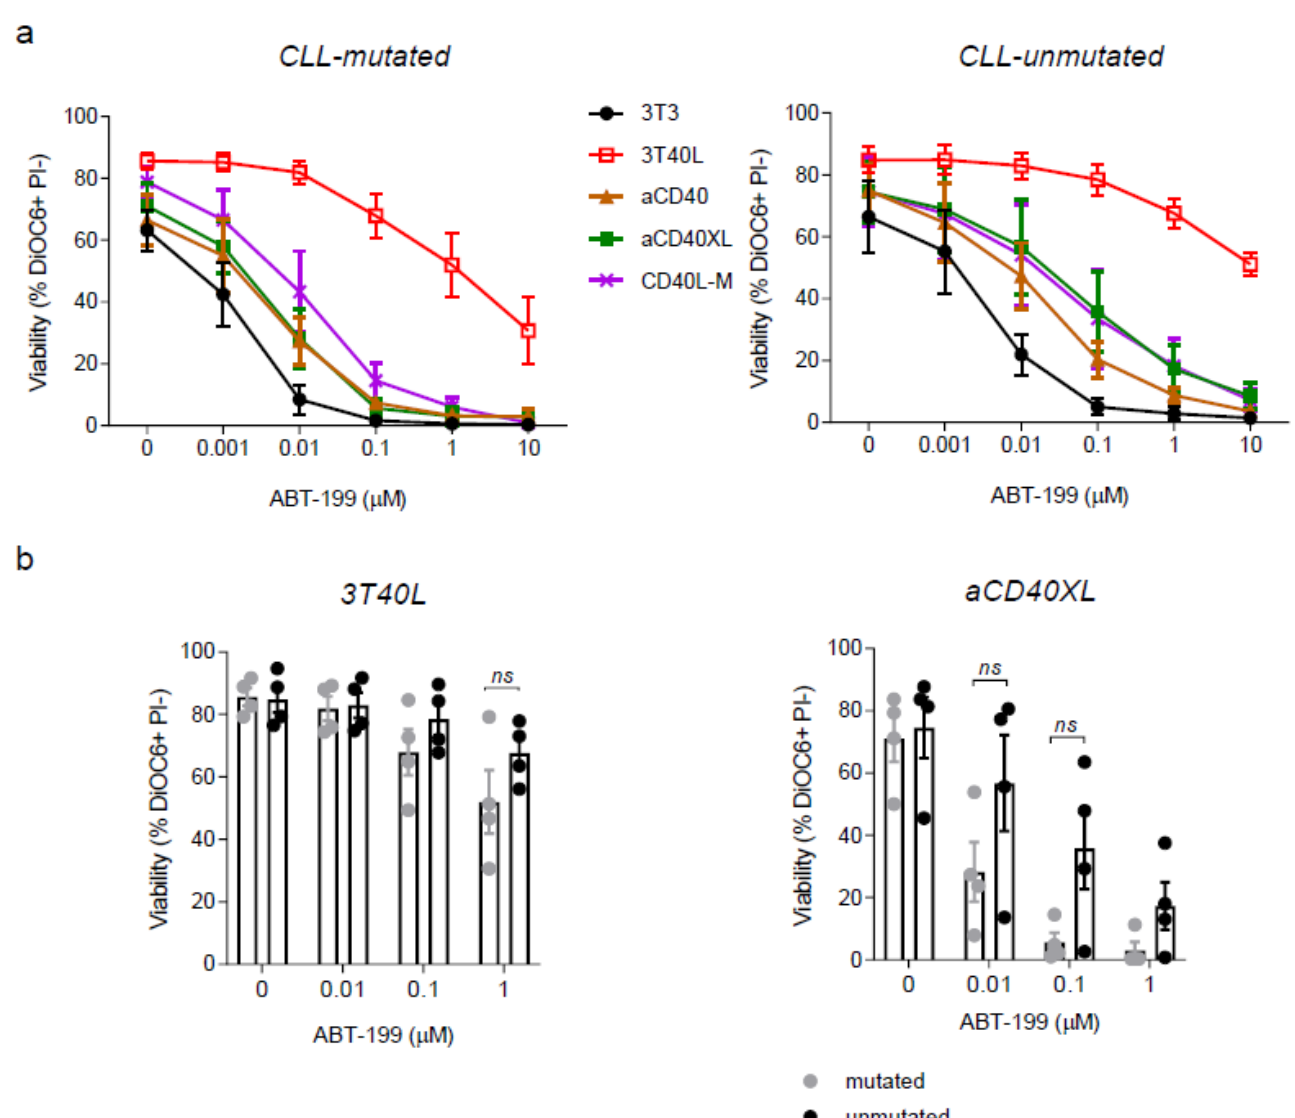
Figure 5. Reduced induction of venetoclax resistance in CLL cells stimulated with selicrelumab compared to coculture with 3T3 cells expressing CD40L. ( a ) CLL cells were cultured and CD40 stimulated as previously described. After 48 h, cells were treated with venetoclax (ABT-199; 0–10 µ M) for 24 h. Viability was measured by flow cytometry using DiOC6 and propidium iodine viability stainings. Results from 4 IGHV-mutated and 4 unmutated patients. ( b ) Data from A depicted side by side to allow comparison of IgVH mutated versus unmutated CLL samples. Bars represent the mean ± SEM: ns (not-significant, unpaired t -test).